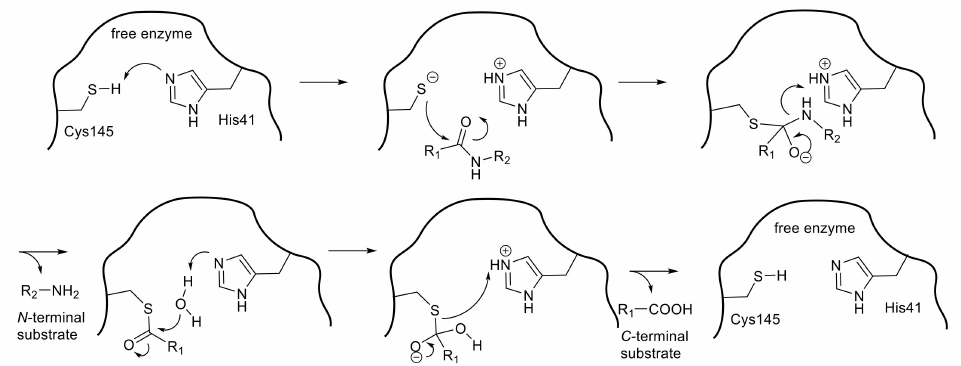
Figure 2. Hydrolysis of the substrate by thiol